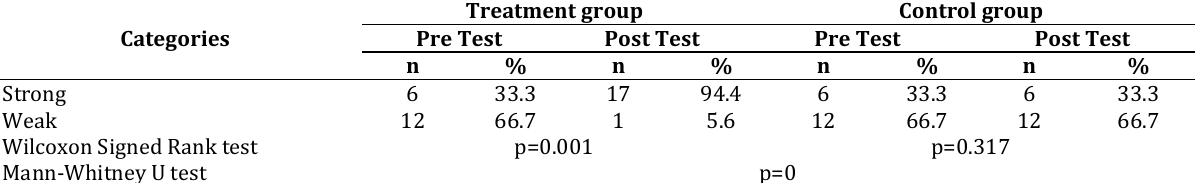
Table 1 The Level of Self-efficacy (n = 18)